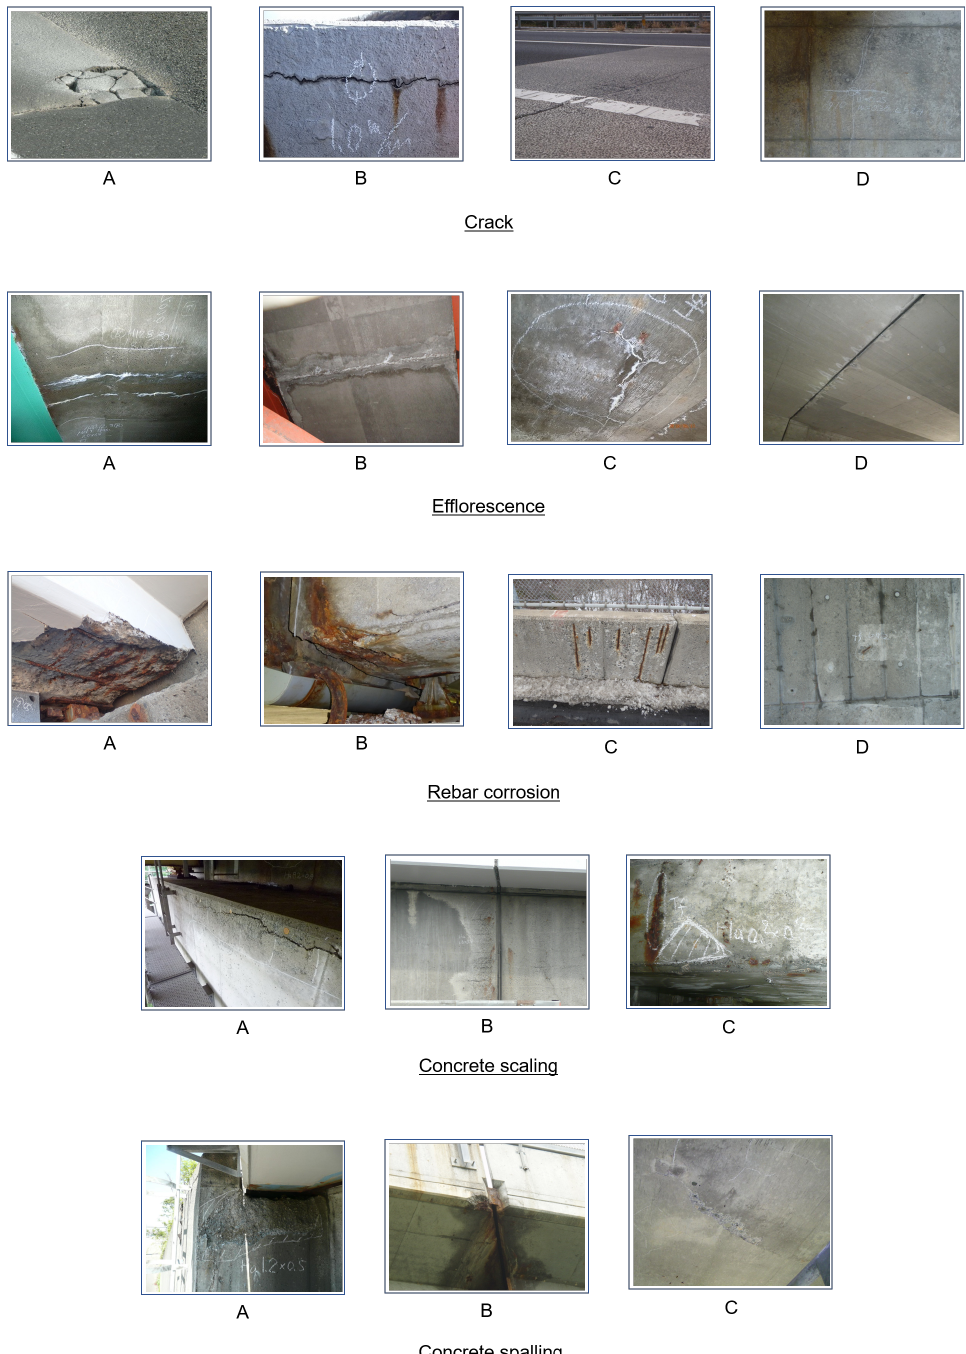
Figure 3. Examples of each degradation degree in the types of crack, efflorescence, rebar corrosion, concrete scaling, and concrete spalling. Crack, efflorescence, and rebar corrosion were evaluated at four degrees, and concrete scaling and spalling were evaluated at three degrees by skilled